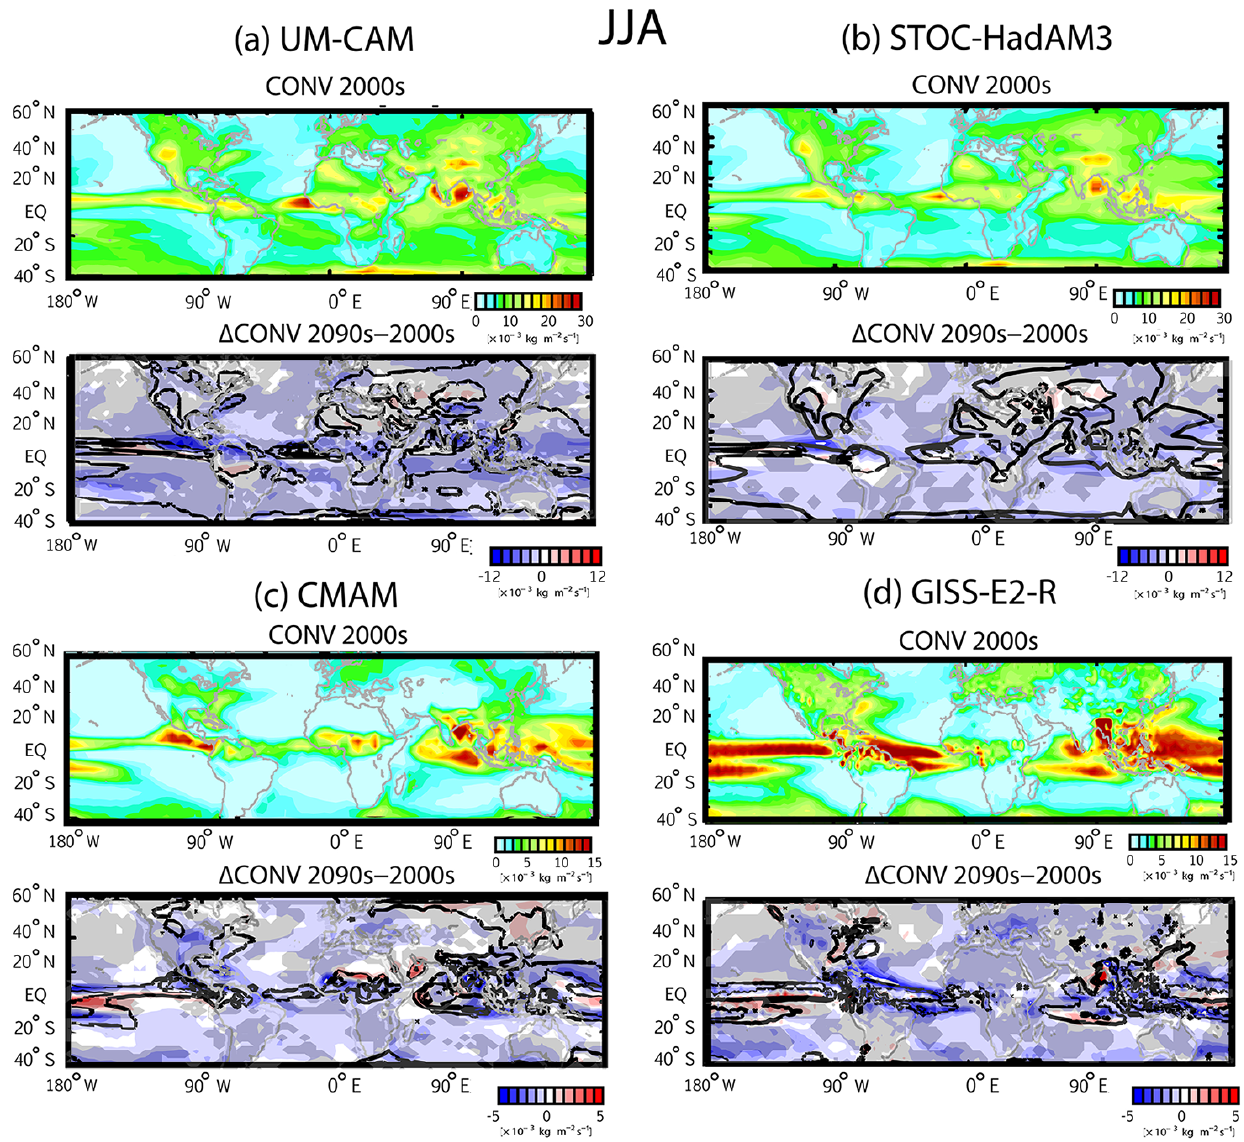
Figure 9. Same as Fig. 8 but for JJA. Note the different scales for (i) UM-CAM and STOC-HadAM3 and (ii) CMAM and